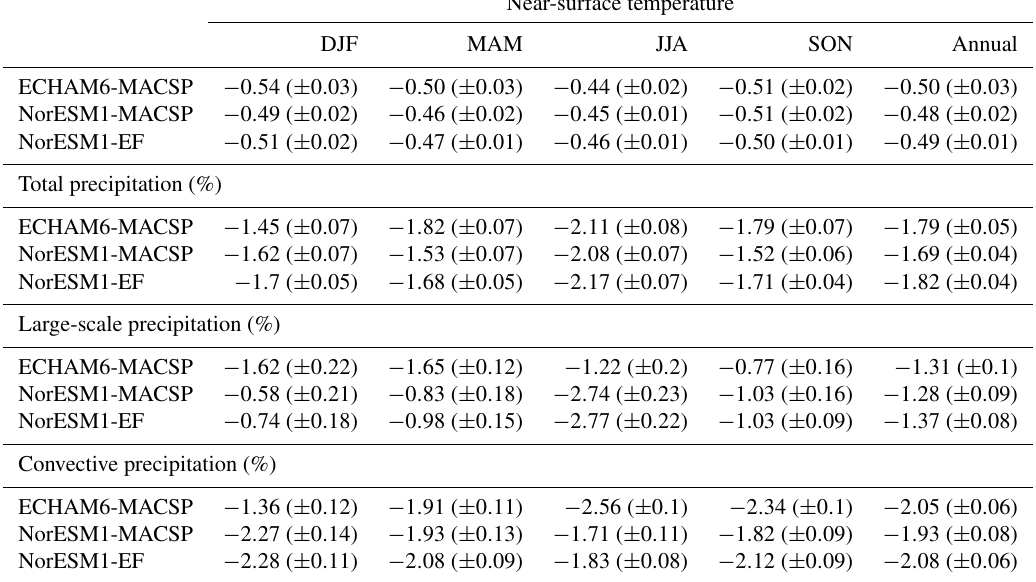
Table C1. Summary of global-mean change of temperature and pre- cipitation due to modern-day anthropogenic aerosols. Error bars are the standard error of